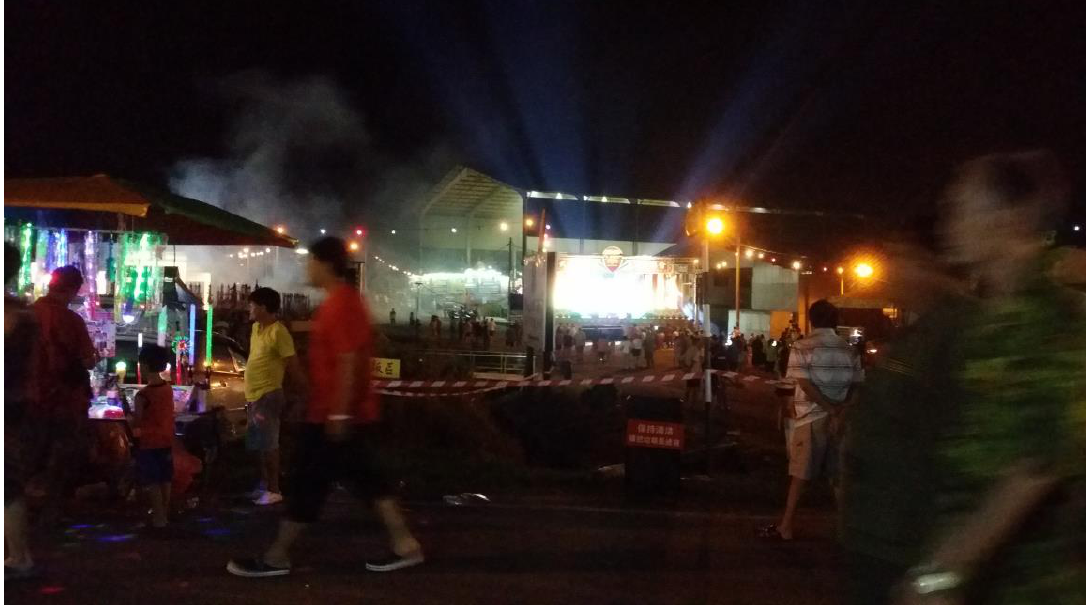
Figure 2. Late night visit to the market with a study participant as a field event. Photo by